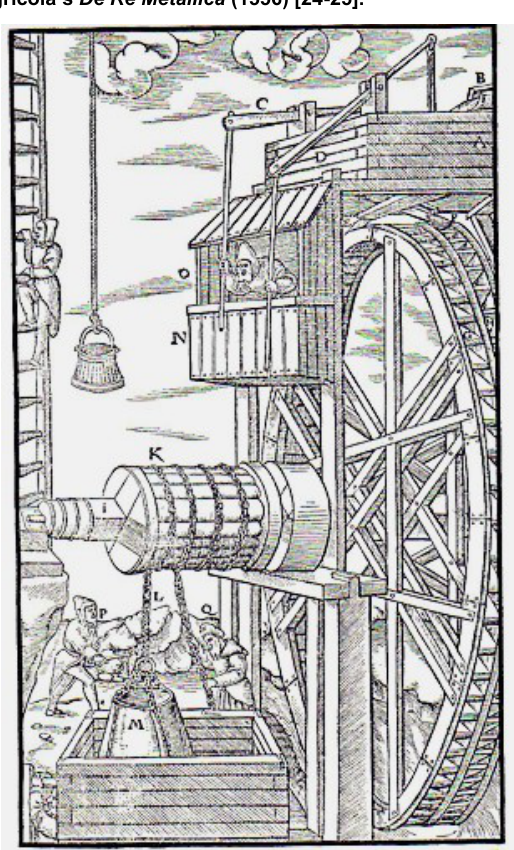
Figure 8.A mine water powered lifting machine in Georgius Agricola’s De Re Metallica (1556) [4, 24-25]. Rotation is reversed by valves activated by the operator permitting water flow towards appropriate